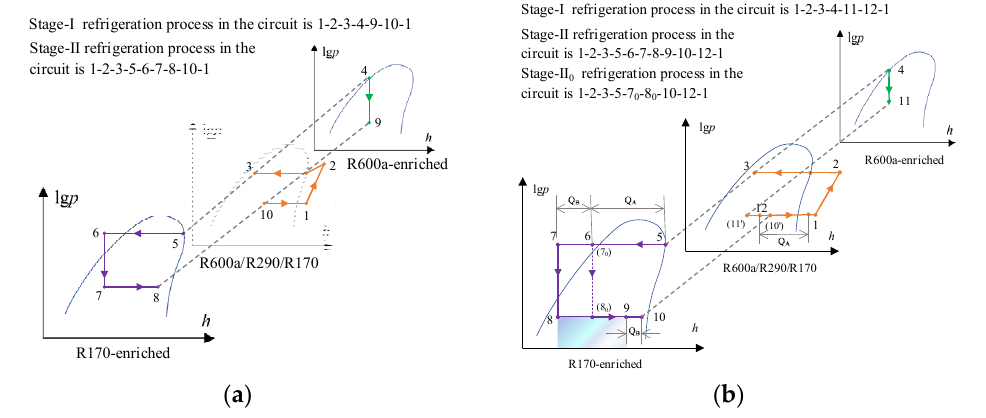
Figure 2. Pressure-enthalpy diagrams of ACRC ( a ) and MACRC ( b ) using R600a/R290/R170. (The yellow lines represent the overall circulation in the process, the green lines represent the stage-I part with R600a-enriched, and the purple lines represent the stage-II part with R170-enriched.)